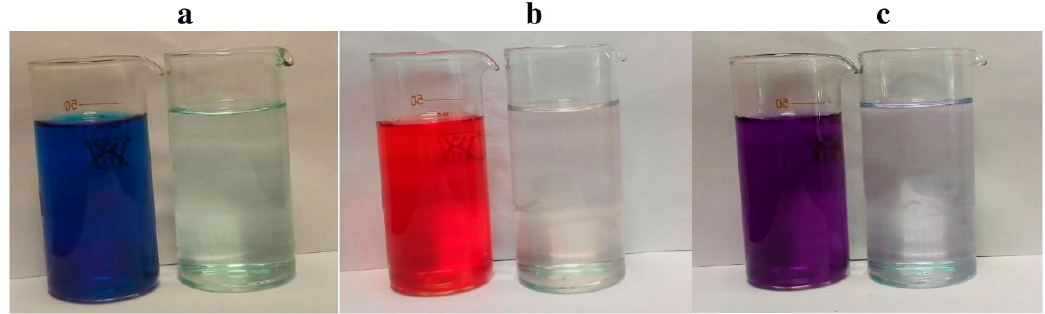
Figure 5. The color of the solution of dyes MC ( a ), CR ( b ) and MV ( c ) before and after adsorption.